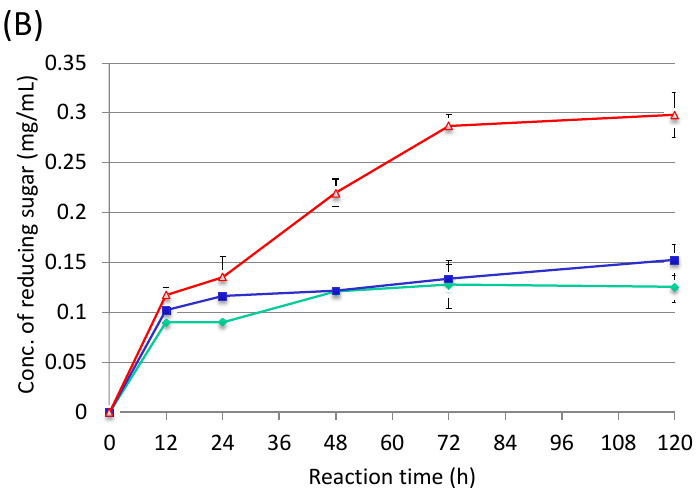
Figure 5. Enzymatic activities of rice straw ( A ) and sugarcane bagasse ( B ) using each purified cellu- losome. Red line, cellobiose cellulosome; green line, rice straw cellulosome; blue line, sugarcane baggase cellulosome.